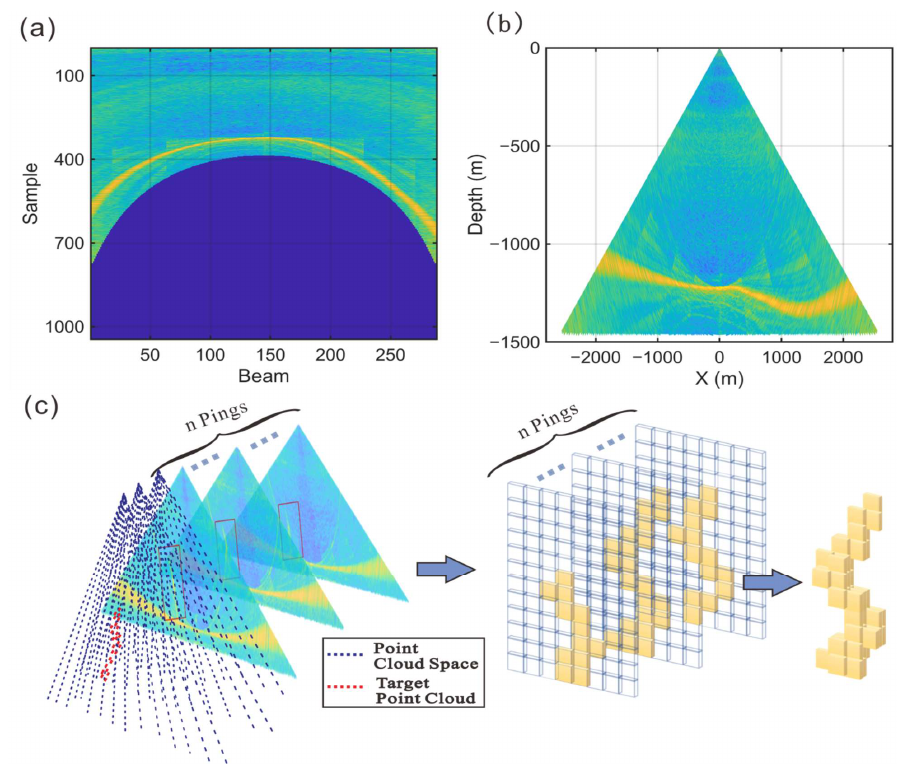
Figure 4. MWC data location model. ( a ) T-A space image (single ping); ( b ) D-A track space image (single ping); ( c ) schematic diagram of MWC point cloud space construction. Time-Angle (T-A) Track Space (Figure 4a): The original point data recorded by MBES. The horizontal axis is marked as the beam number, indicating the beam trans- mission angle, and the vertical axis represents the sampling sequence. In this display, the bottom is displayed in a near-parabolic shape, and because the beam in the edge direction has its beam footprint significantly widened, the bottom echo signal ob- tained in that direction is not obvious in its bottom region and presents a widening of the bottom region on the image. Depth-Acrosstrack (D-A) Track Space (Figure 4b): The point data after spatial hom- ing. By converting the polar coordinate position of the water sampling point into the absolute coordinate position, the underwater image environment of the water infor- mation can be restored more truly. Cartesian coordinate transformation was carried out for each ping sampling point in the MWC data, and all ping sampling points were reconstructed in space to complete the initial construction of the MWC point cloud space (Figure 4c).